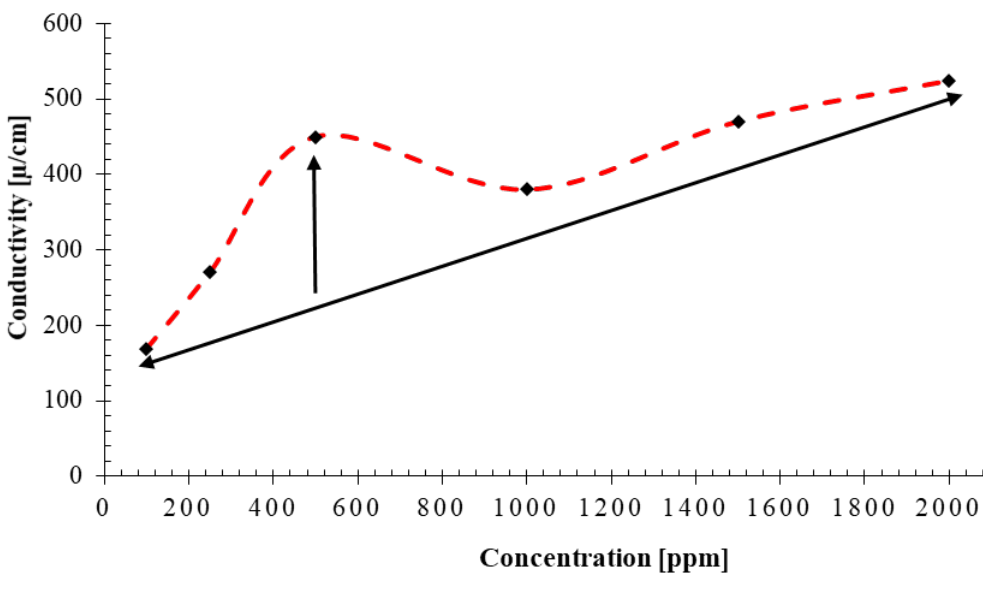
Figure 11. Conductivity of the prepared nanofluids. The minimum and maximum conductivity of 169 µ S / cm and 524 µ S / cm are recorded for NC concentrations of 100 ppm and 2000 ppm, respectively. An abnormally high conductivity of 480 µ S / cm is recorded for the nanofluid with NC concentration of 500 ppm.